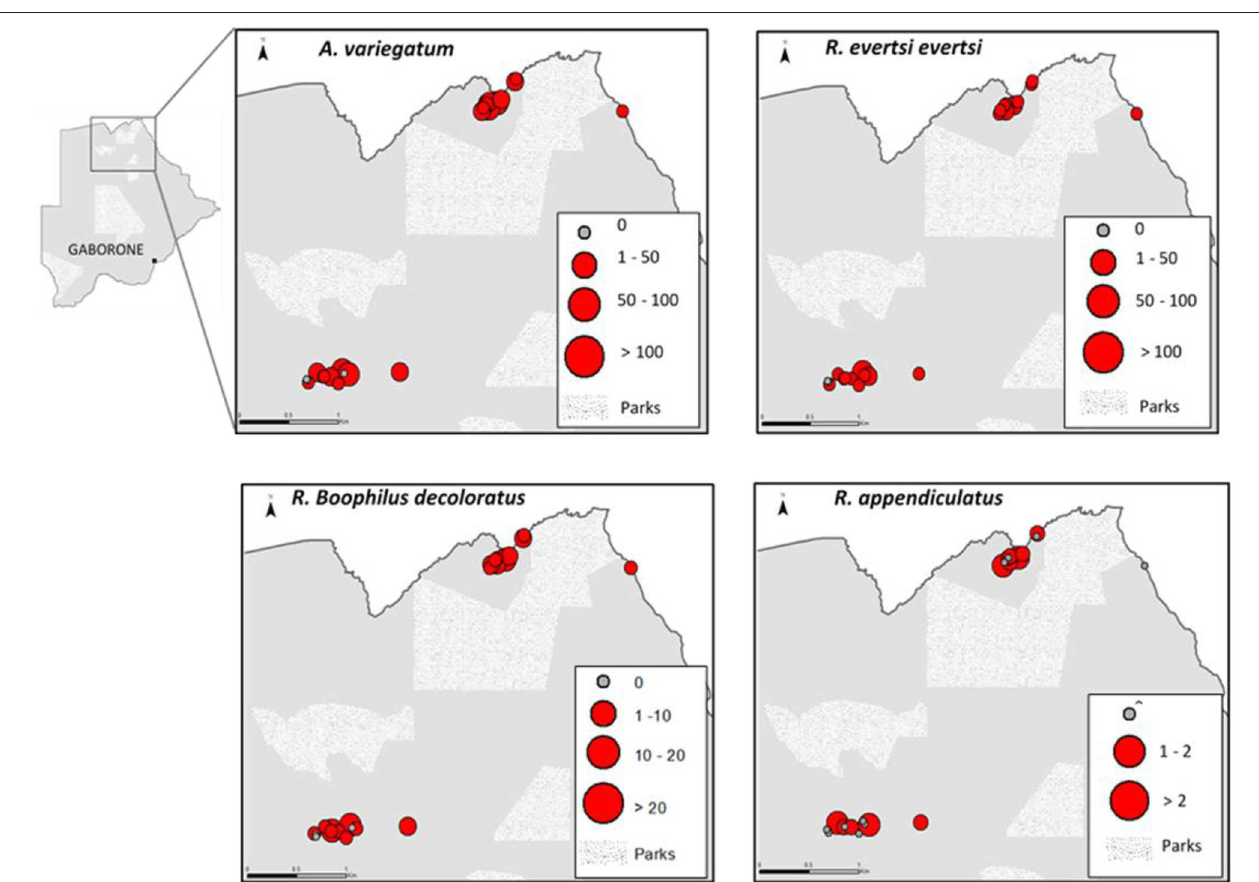
FIGURE 2 | Spatial distribution of tick species at the wildlife-livestock interface in northern Botswana (Maun west and Chobe west).